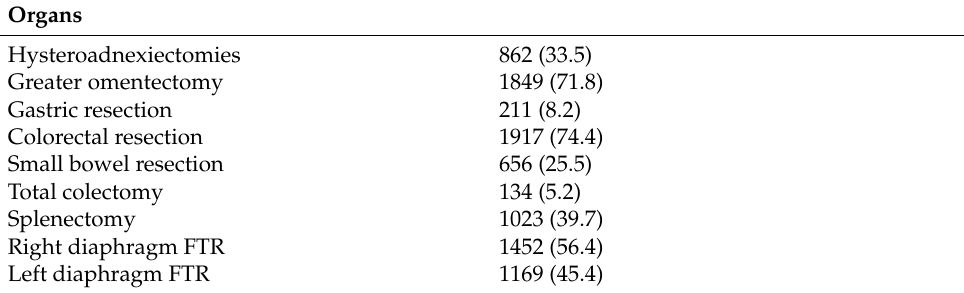
Table 3. Surgical procedures N (%), (total 2576